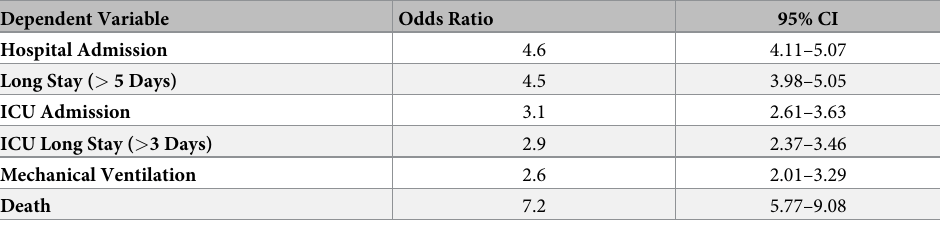
Table 2. Odds ratios for adverse outcomes in Veterans diagnosed with COVID-19 and a CAN score greater than 50.